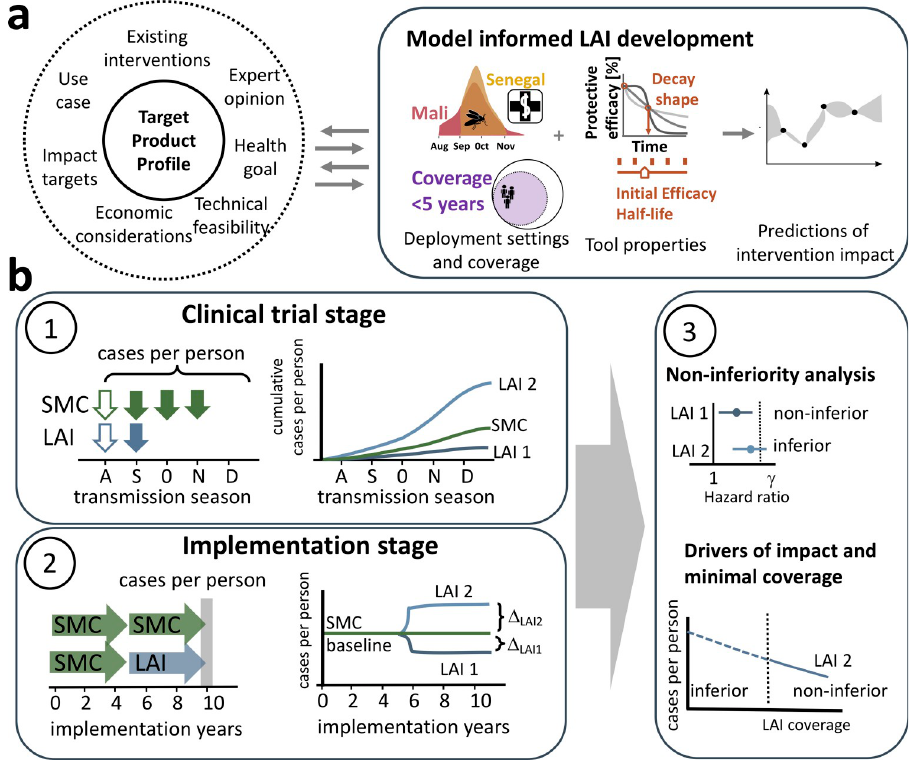
Fig 1. Workflow to assess the target product profile of LAIs. (a) In an iterative exchange between various stakeholders, definition of TPPs is informed by results from modelling approaches. Simulation of predefined scenarios with OpenMalaria , an individual-based model of malaria dynamics, allows to predict the likely intervention impact (incidence reduction, indicated by the model symbol) of LAIs in the context of deployment setting details (access to healthcare (indicated by the hospital symbol) and seasonality (indicated by the mosquito icon), deployment coverage of the target population and the tool properties (initial protective efficacy against infection, protective efficacy half-life and decay of protective efficacy). The resulting evaluation of LAI impact is communicated and discussed with stakeholders to refine the analysis as LAIs are developed. (b) The analysis in the clinical trial and implementation stage are illustrated on the example of two hypothetical LAIs with different efficacy profiles (denoted LAI 1 and 2). (1) In clinical trial stages, the minimum essential properties to reach a certain health goal are evaluated in a two-arm clinical trial. SMC with SP+AQ is administered (green arrows) three time during the months of September (S), October (O), and November (N) (as in Senegal, filled green arrows) or four times as well as in August (A) (as in Mali, filled and unfilled green arrows) times over the transmission season. LAIs are administered once at the beginning of the transmission season (blue filled arrow for Senegal or blue empty arrow for Mali). The cumulative cases per person over the trial period are tracked. (2) In implementation stages, SMC-SP+AQ is replaced with LAIs after five years of implementation. Impact is assessed in the last implementation year (grey bar) and compared to the baseline of SMC-SP+AQ implementation. Coverages of SMC-SP+AQ and LAIs are independent from each other. (3) Upper panel: The tool properties influencing the establishment of non-inferiority of LAIs to SMC are investigated in the clinical trial stage. Lower panel: At a fixed SMC deployment coverage, the minimum coverage of LAI deployment required to establish non-inferiority is identified.